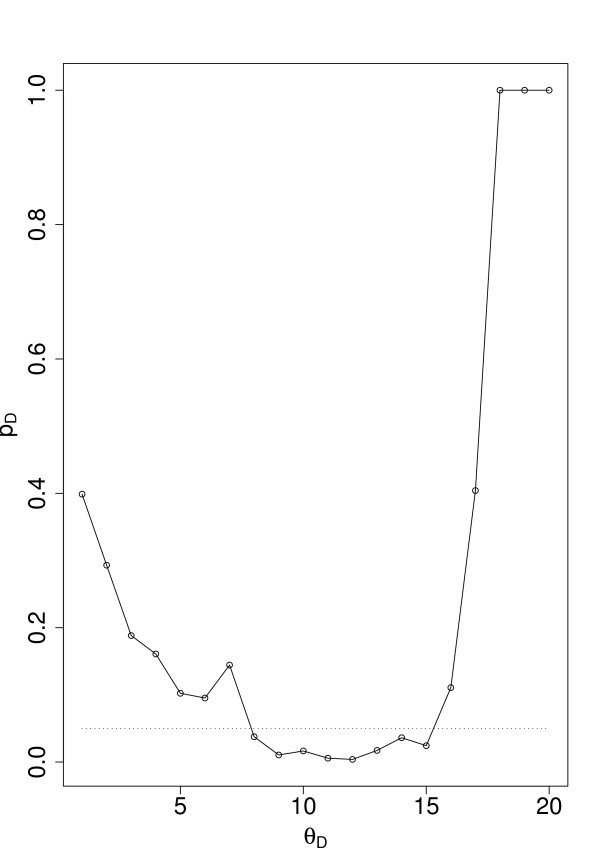
pD in dependence on ΘD. The dotted line corresponds to 0.05.